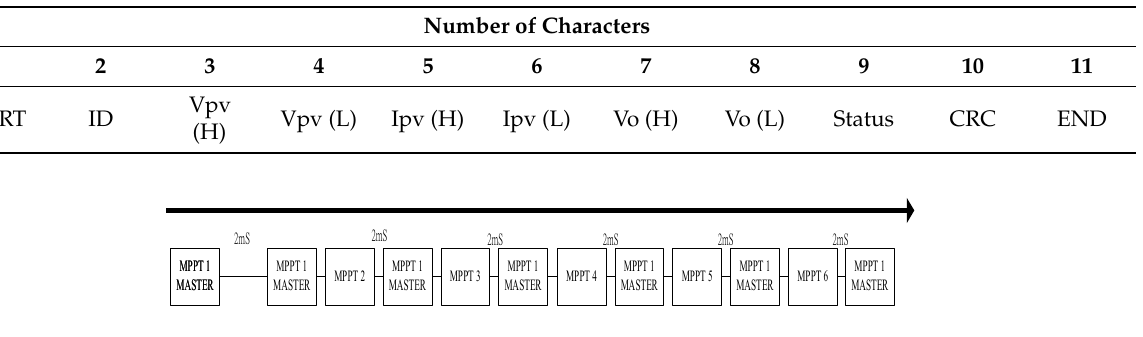
Table 2. The protocol of slave receiving message.